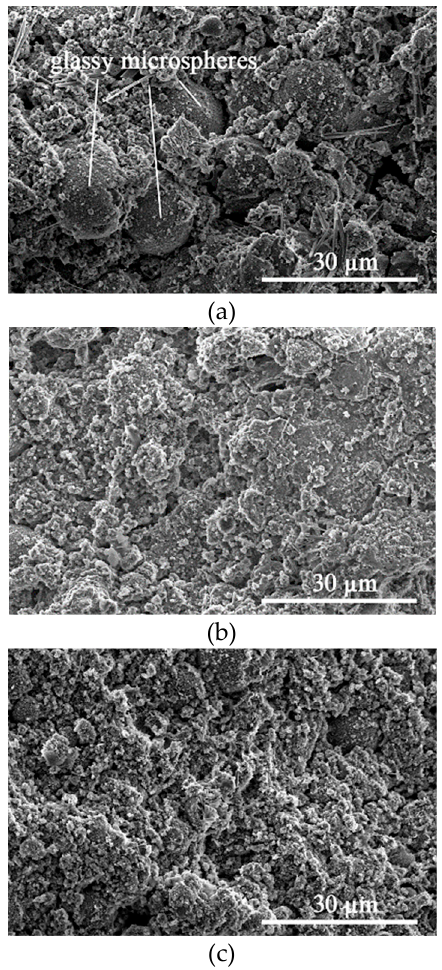
Figure 6. SEM images of M10: ( a ) before attack, ( b ) HCl-attack for 28 d and ( c ) Na 2 SO 4 -attack for 28 d.